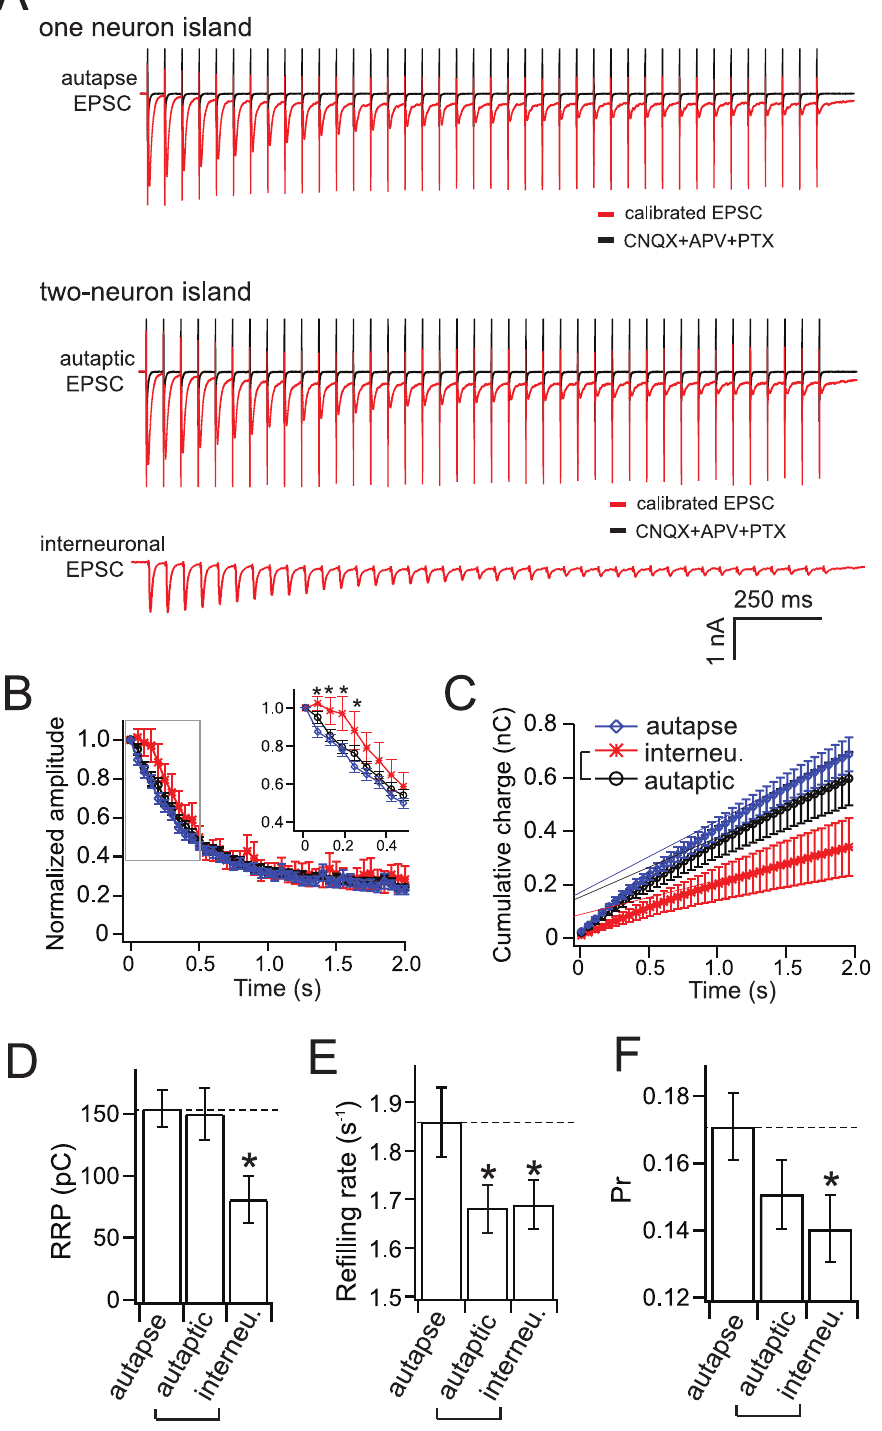
Figure 5. Synapses in two-neuron micronetworks display increased short-term plasticity, compared to autapses. (A) Representative EPSCs triggered by high-frequency stimulation (HFS, 40 APs/2 s) of autapses and two-neuron micronetworks. Calibrated EPSCs were calculated by subtracting the offset current, determined in the presence of CNQX to block AMPA receptors, from the original EPSC. (B) The peak amplitude of each EPSC normalized to the peak of the first response and plotted versus time. Note that autapses and autaptic synapses underwent immediate depression after the first few APs, compared to interneuronal synapses. Inset is a magnification of the graph in the indicated box, showing the responses to the first 10 stimuli. (C) Plot of cumulative total charge versus time. Data points from the 30 th to the 40 th EPSC were fitted with a linear function. The y-intercept is a measure of the RRP size (D), and the slope divided by the RRP size (to eliminate any influence of different RRP sizes between groups) reveals the SV refilling rate (E). (D) The RRP size in interneuronal synapses is smaller (81.8 6 18.7 pC) than in autaptic synapses in two-neuron networks (150.3 6 20.5 pC) or in autapses (153.9 6 14.7 pC). (E) The synaptic vesicle refilling rates during HFS were significantly reduced in